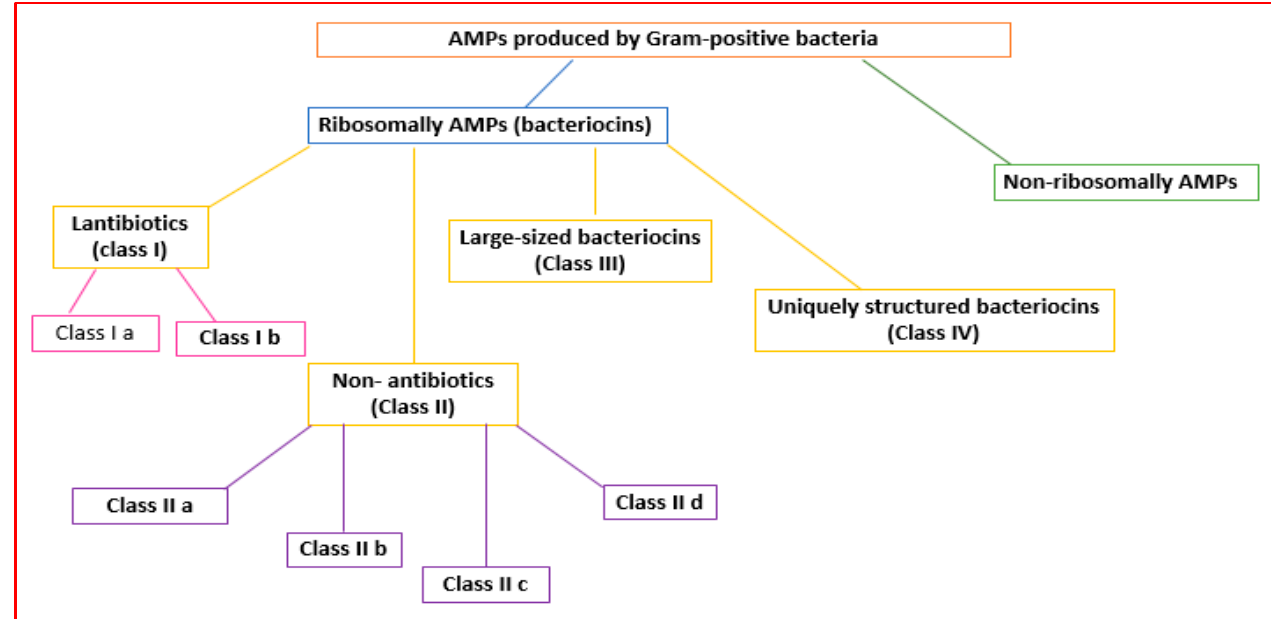
Figure 2. Classification of the AMPs produced by Gram-positive